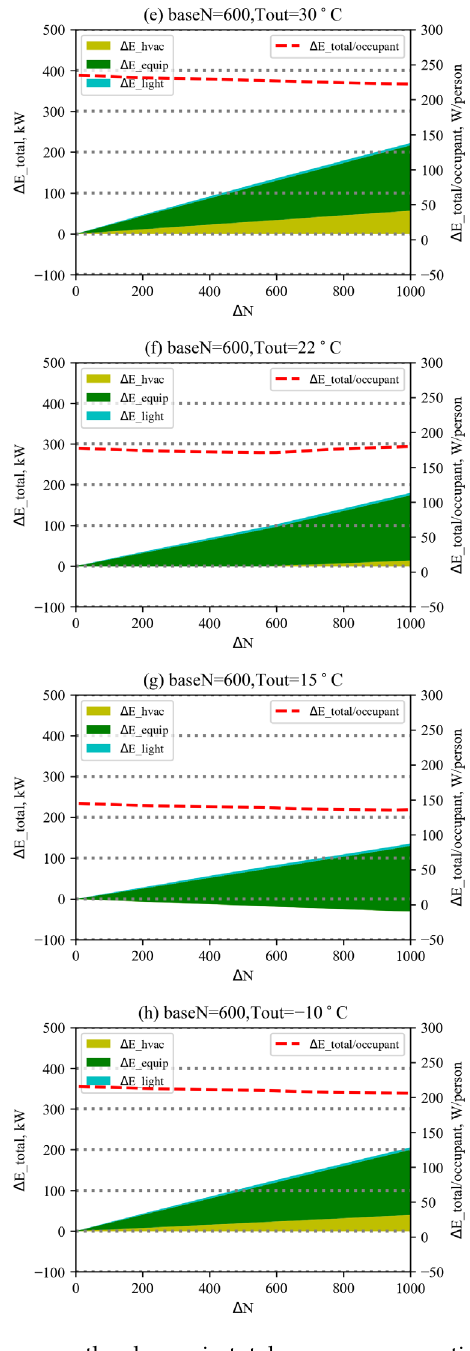
Figure 11. The influence of occupancy on the change in total energy consumption with different baseN and T out (variable fresh air volume). baseN and T out (variable fresh air